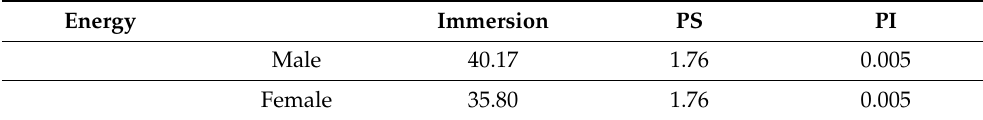
Table A6. There is a 75% chance of low Energy for the given values of Immersion setting PS and PI to their medians for participants who are not sick. The PI values are unstandardized.